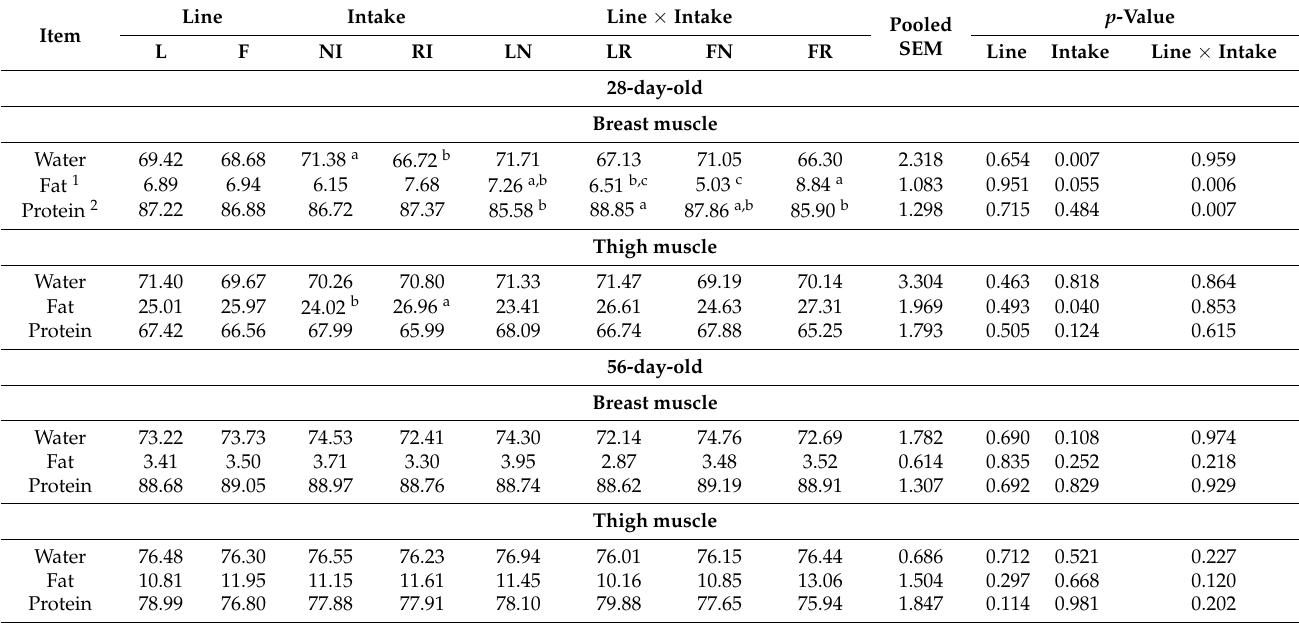
Table 5. Effect of feed intake on water, crude fat, and crude protein content of offspring muscle in broiler hens during laying period (n =